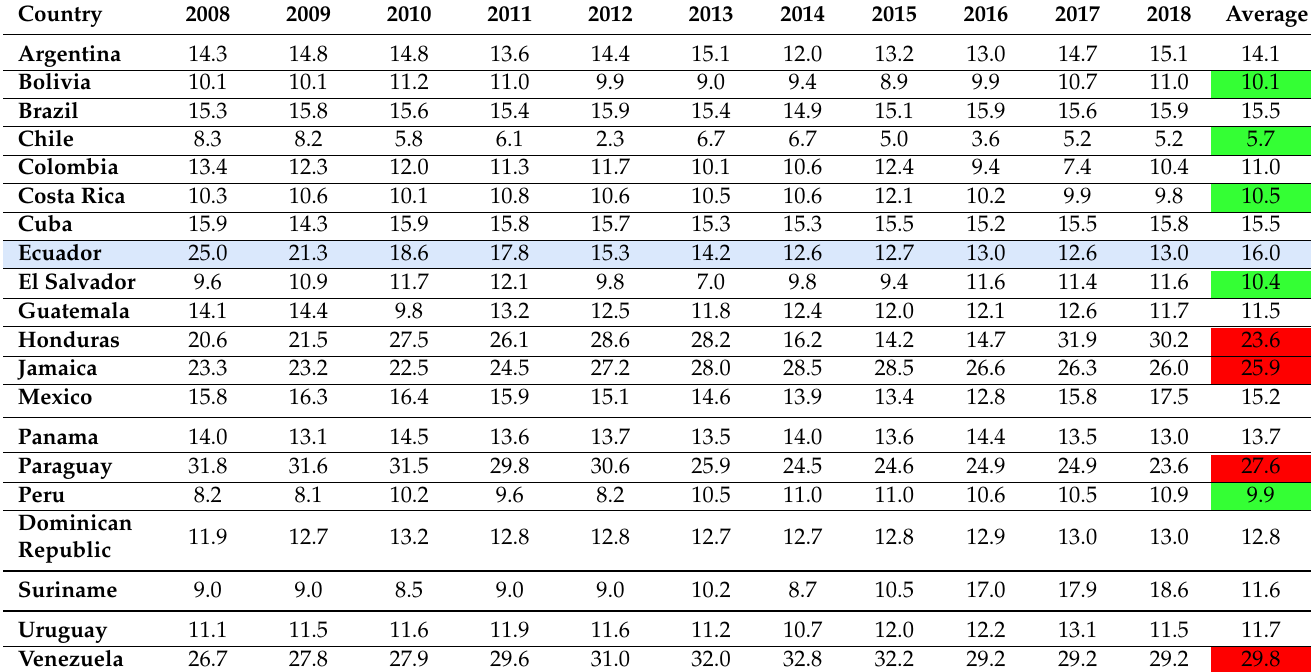
Table 1. Non-technical energy losses in